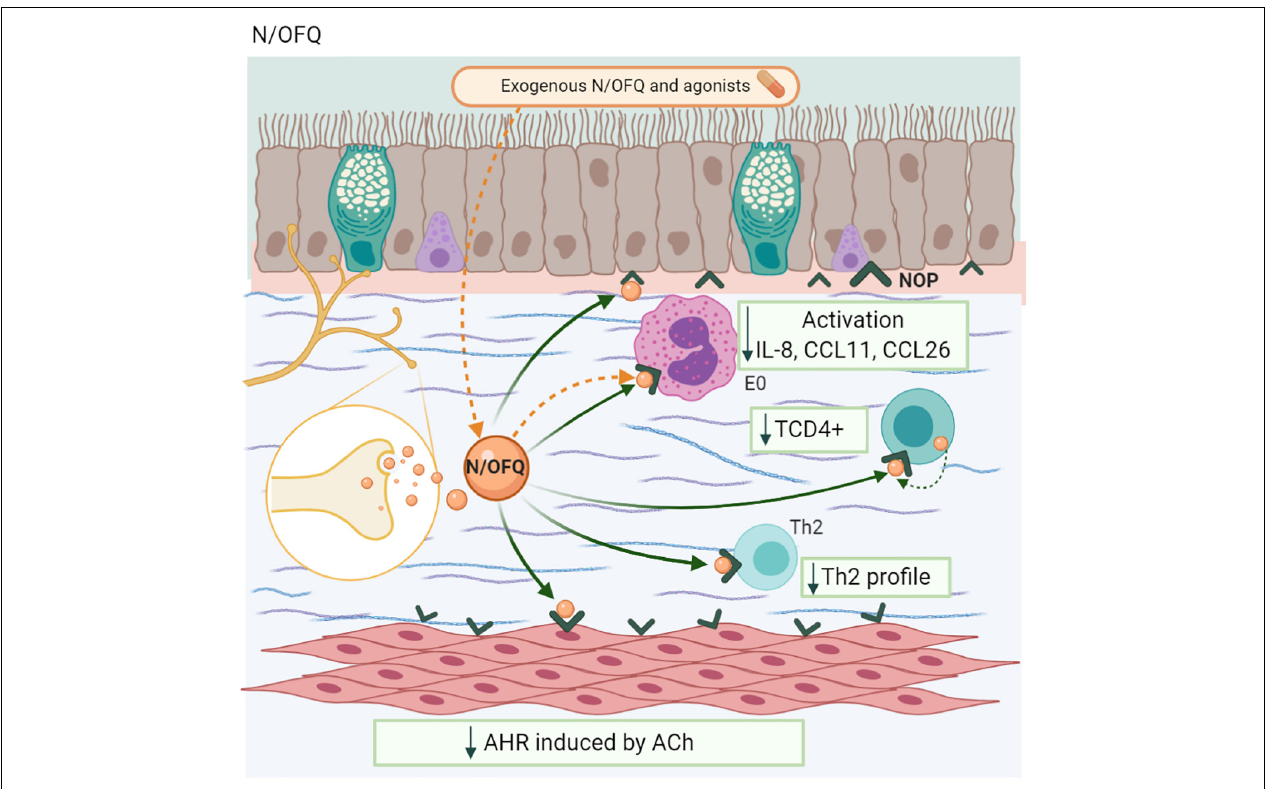
FIGURE 9 | Nociceptin/orphanin FQ-N/OFQ. Neurons and lymphocytes produces this NP. The coupling with its receptor (NOP) decreases TCD4 + population, Th2 profile synthesis, the eosinophil chemotaxis as well as its activation, and the airway hyperresponsiveness (AHR) induced by